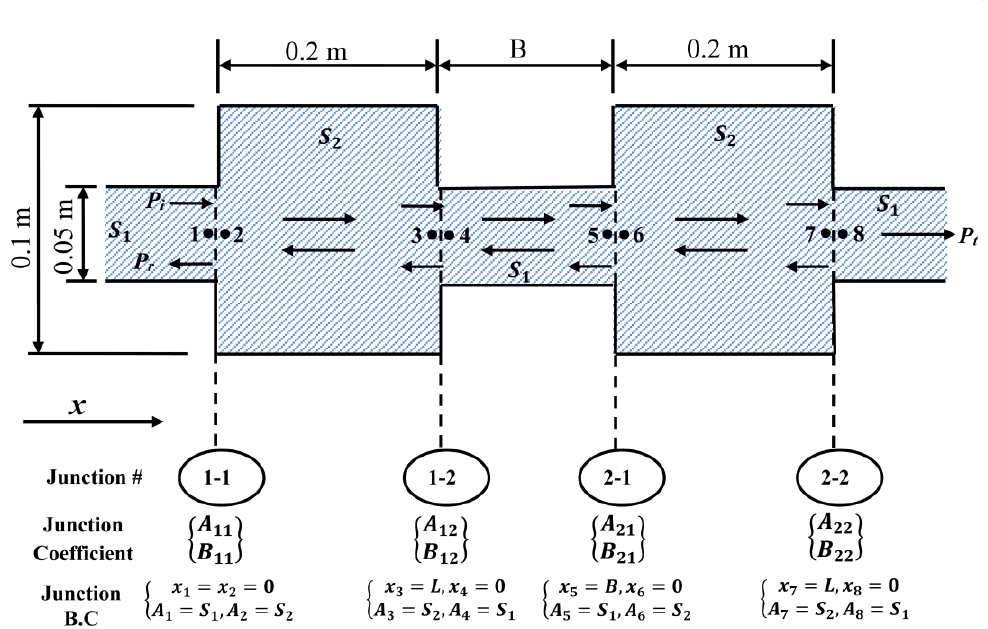
Figure 4. The mathematical space constraints for DCLCM.